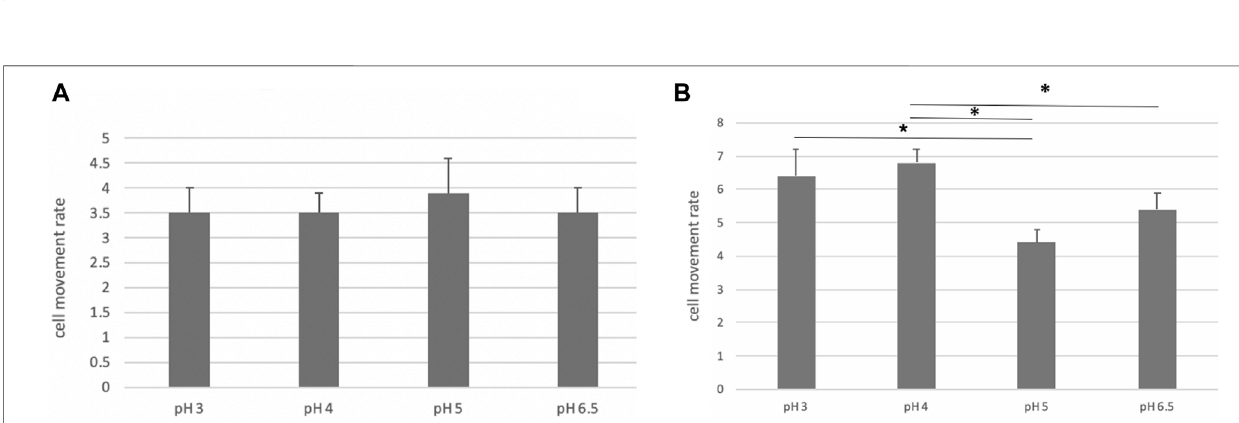
Frontiers in Pharmacology |